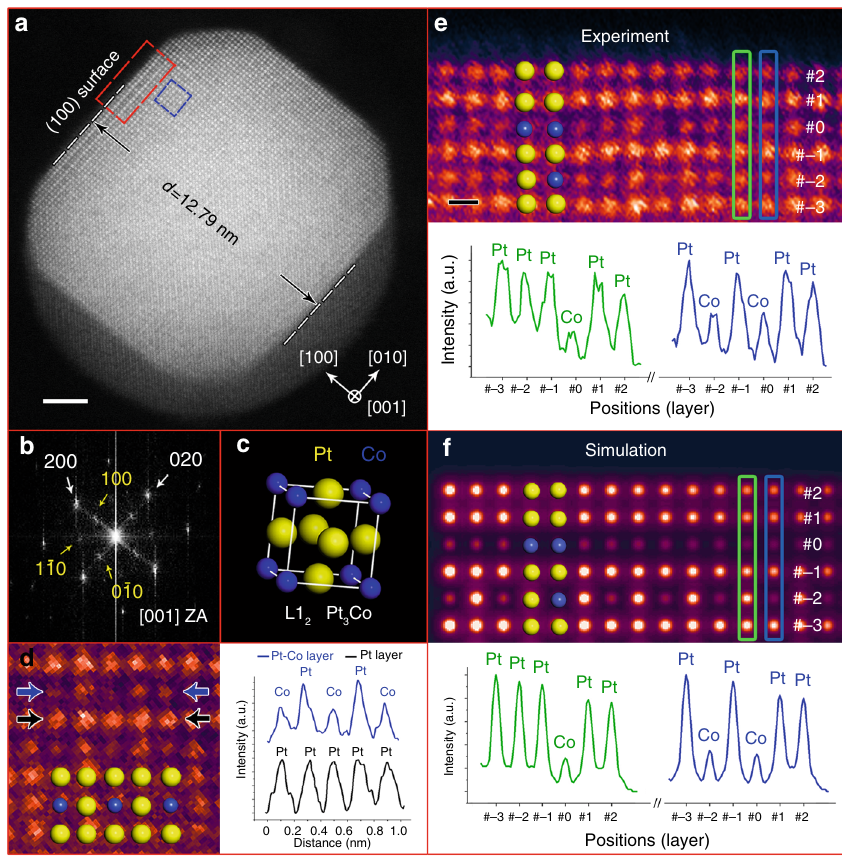
Fig. 2 In situ results from a Pt 3 Co NP after oxygen annealing at 720 °C. a HAADF-STEM image taken inside the gas cell showing the Pt 3 Co NP after a 30-min annealing in oxygen atmosphere. Scale bar, 2 nm. b FFT pattern of the NP in a . c Unit cell of the L1 2 phase illustrating the ordered intermetallic Pt 3 Co structure. Yellow and blue spheres represent Pt and Co atoms, respectively. d A false-colour cropped image of the ordered intermetallic feature taken from the blue box in a and the intensity pro fi les taken along the lines indicated by the blue and black arrows , respectively. e Enlarged false colour image of the (100) surface taken from the red box in a , and the intensity pro fi les taken along the atomic layers marked by green and blue rectangles showing the segregated Pt-rich surface. Scale bar, 2 Å. f Simulated HAADF-STEM image of a L1 2 intermetallic Pt 3 Co model with Pt-segregated surfaces, and the intensity pro fi les from the two atomic layers marked by green and blue